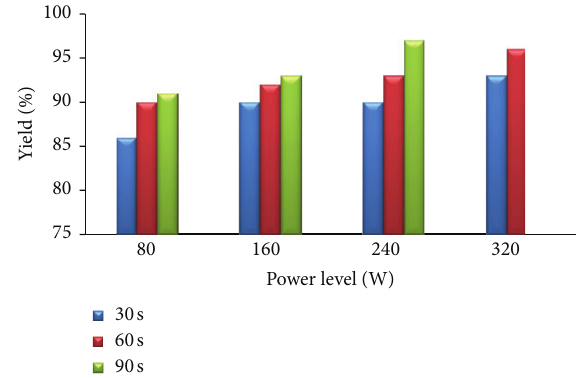
Figure 2: Power level versus yield (%) for the preparation of the compound (2b) under MWI method.